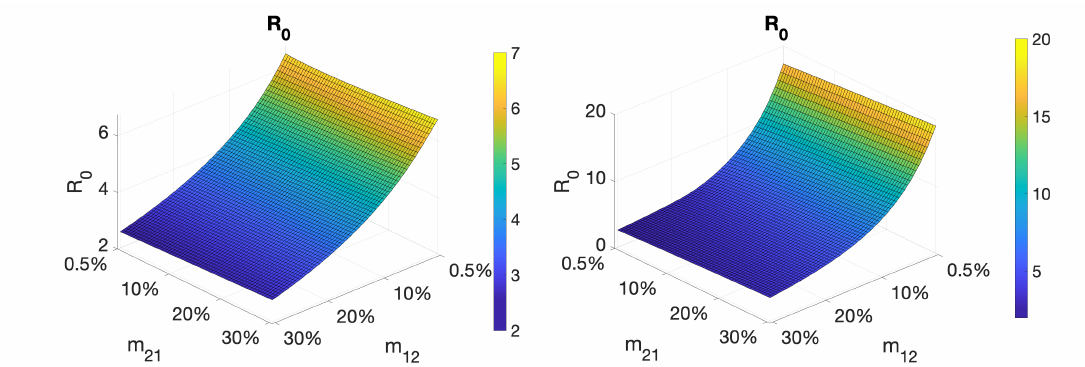
Figure 7. Effect of mobility ( m ij ) on the global R 0 . The global R 0 is displayed as a function of m 12 and m 21 . The left panel with the transmission rate β 1 = 0.338 in Daegu and Gyeongbuk and a transmission rate β 2 = 0.357 in the rest of Korea. The right panel with the transmission rate β 1 = 0.9 in Daegu and Gyeongbuk and a transmission rate β 2 = 0.357 in the rest of